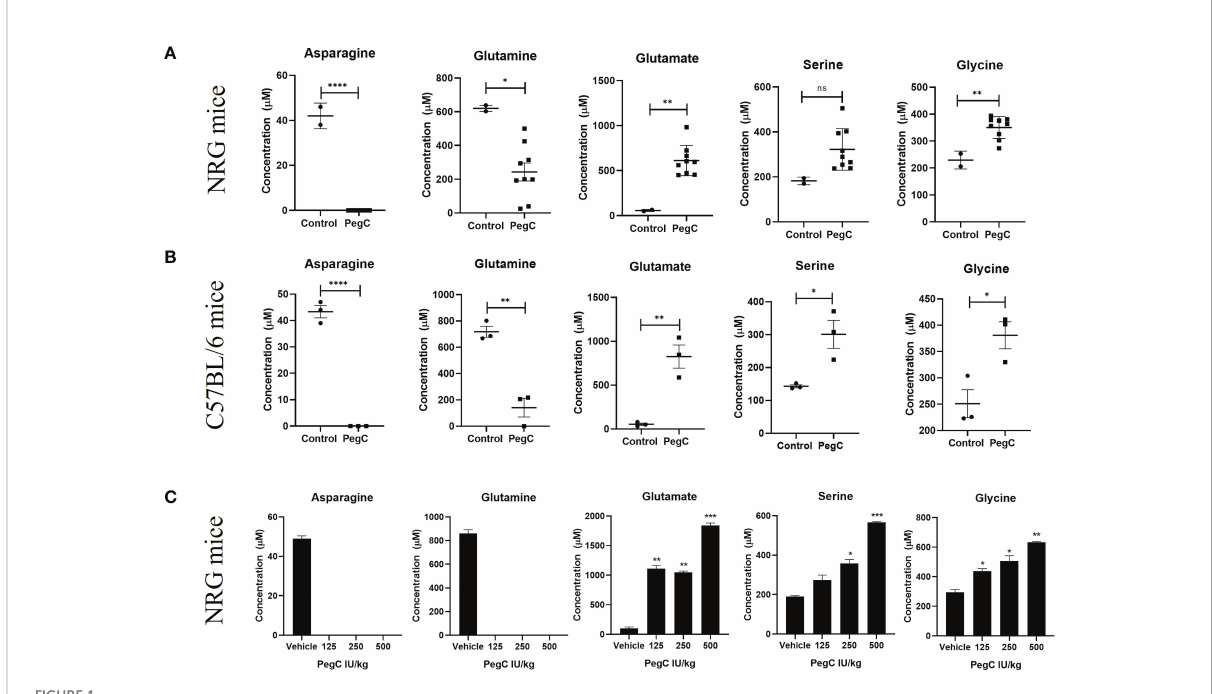
FIGURE 1 PegC-induced plasma amino acid changes in non-tumor bearing mice. (A) NRG mice were treated with vehicle (n=2) or PegC (n=9, 200 IU/kg, IV, 1x/ week) for 4 weeks. Plasma was isolated from whole blood obtained at the end of the study and HPLC was performed to measure the concentration of the indicated amino acids. (B) C57BL/6 mice were treated with vehicle (n=3) or PegC (n=3, 200 IU/kg, IV, 1x/week) for 4 weeks. Plasma was isolated from whole blood obtained at the end of the study and HPLC was performed to measure the concentration of the indicated amino acids. (C) NRG mice were treated with vehicle (n=2) or PegC 125 IU/kg (n=2), PegC 250 IU/kg (n=2), or PegC 500 IU/kg (n=2). Plasma was isolated from whole blood obtained three days after treatment and HPLC was performed to measure the concentration of the indicated amino acids. Statistical analyses